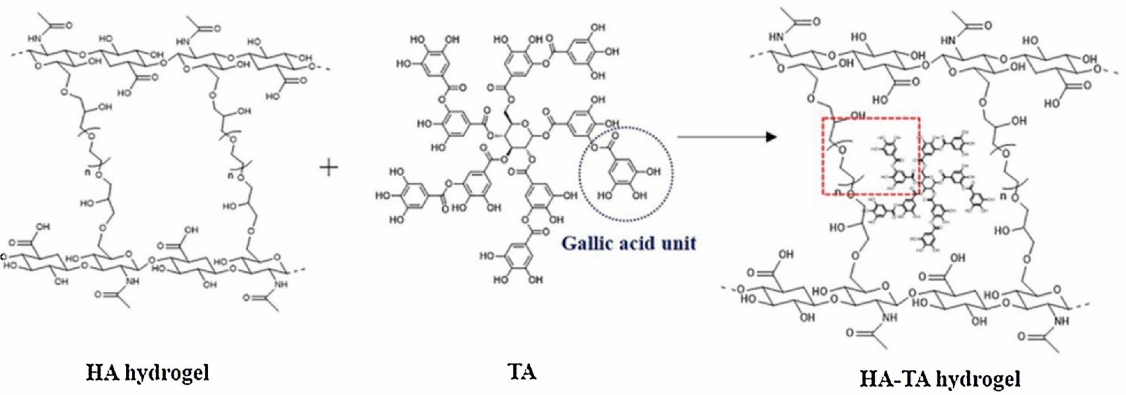
Figure 11. Chemical cross-linking of hyaluronic acid and PEGDE system using tannic acid [104]. Reproduced with permission from Elsevier